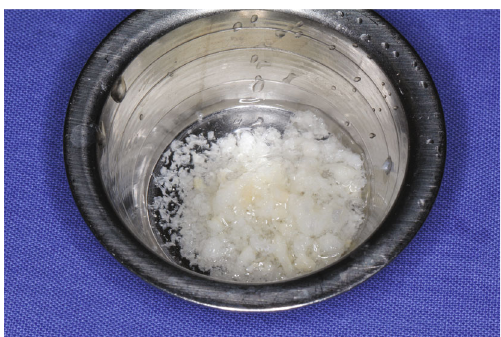
Figure 11: Processed human allograft (Maxgraft®; corticocancellous granules; Cells + Tissuebank Austria, Krems a. d. Donau, Austria).